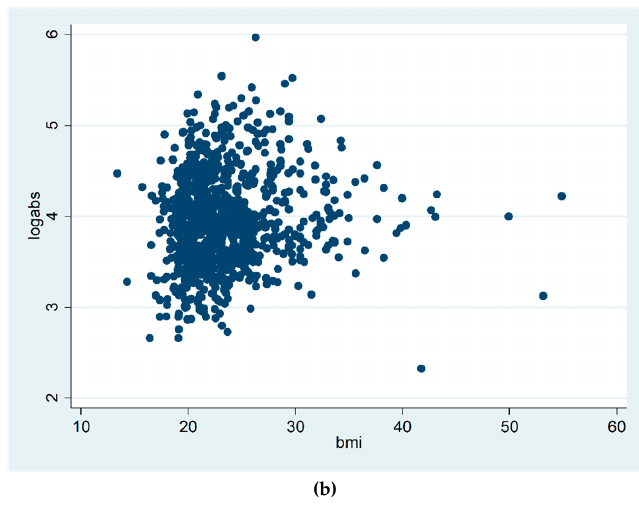
Figure 2. Log percent breast density by BMI ( a ). Log absolute breast density by BMI ( b ).